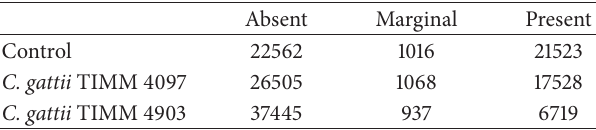
Table2:Theprobabilityofthevalueofeachdatapointwasindicated as a “flag,” such as “present” ( 𝑃 ≤ 0 to < 0.04), “marginal” ( 𝑃 ≤ 0.04 to < 0.06), or “absent” ( 𝑃 ≤ 0.06 to < 0.5). Gene expression that containedthe“absent”flag(expressionof39,181genes)wasexcluded, and the expression of 5,920 genes was